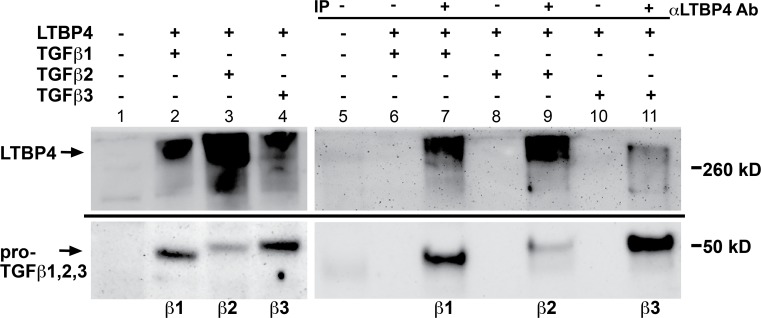
LTBP4 binds TGFβ 1, 2, and 3 isoforms.HEK293T cells were co-transfected with LTBP4 and either TGFβ1, TGFβ2, or TGFβ3. Cell lysates were immunoprecipitated with an antibody to LTBP4 and immunoblotted with an antibody to the FLAG tag on TGFβ1, TGFβ2, and TGFβ3. The immunoblot shows that all three of the TGFβ isoforms associate with LTBP4.